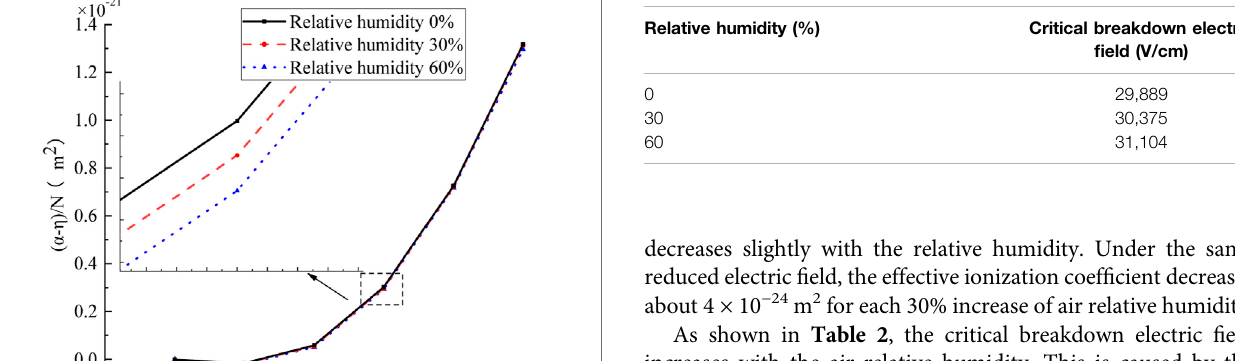
TABLE 2 | Critical breakdown electric fi eld under different